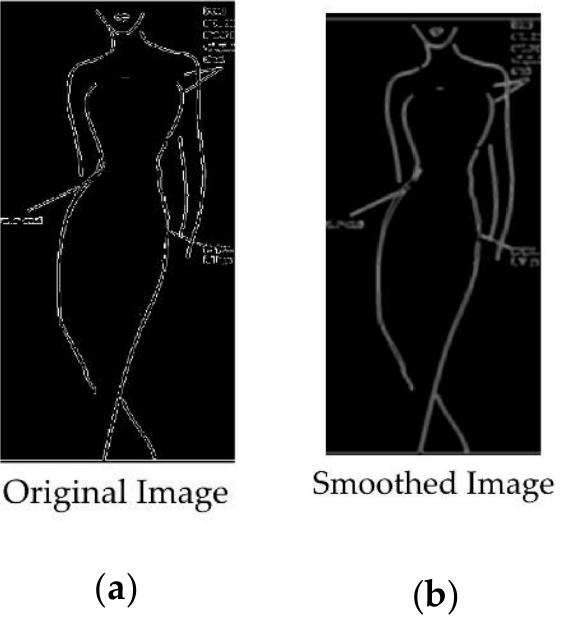
Figure 3. ( a ) The edge detected image, and ( b ) Gaussian smoothed image with σ = 0.5. In this paper, we considered four types of body shapes: inverted triangle, pear, hourglass, and rectangle shapes. Each category of body shape consists of 20 labeled images. The obtained database was divided into training and testing sets. For validation, both hold-out and leave-one-out approaches were assessed. For the hold-out validation approach, 70% of the total number of images was used to train the model and 30% was used for validation [30] (see Figure 4). Hence, 14 images from each category resulting in 14 × 4 = 56 images were used for training the model. On the other hand, 30% of the data were randomly held out for validation [31]. As a result, the remaining 24 images (six for each category) has been used to validate the model. The leave-one-out method was also assessed where the machine learning model is applied once for each image from the database, using all other images as the training data, and the selected image as a single test image [32]. Therefore, the algorithm was simulated 80 times, each time taking 79 images as training data and remaining image as the testing image,